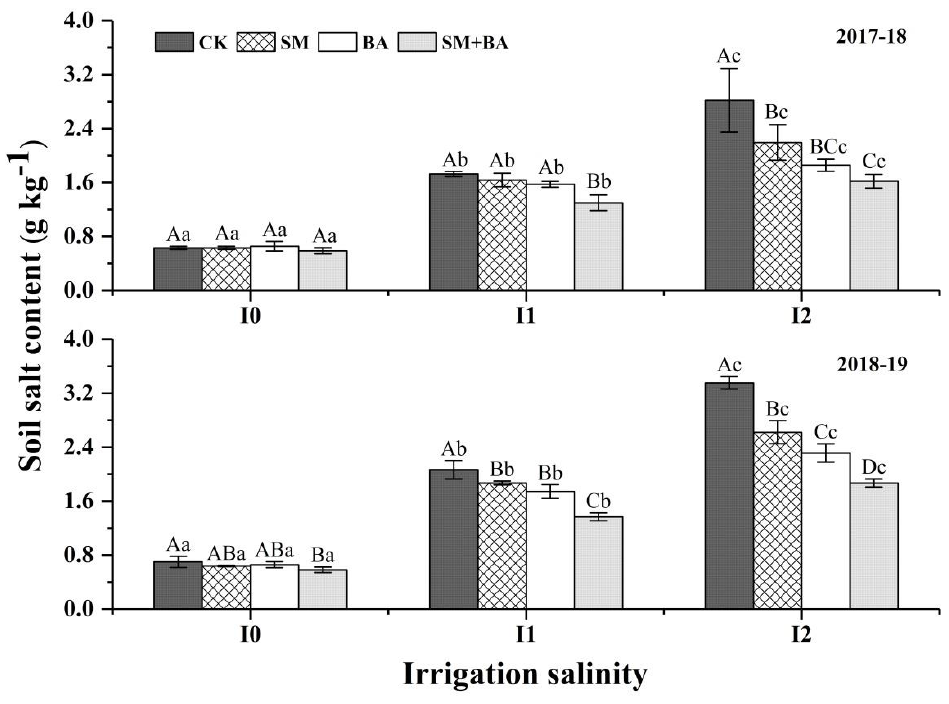
Figure 5. The effects of straw-returning modes and irrigation water salinity on soil salt content in 2017–2018 and 2018–2019, respectively. The values are means of three replications, ± standard deviation. For each growing season, different uppercase and lowercase letters indicate a significant difference ( p < 0.05) among straw-returning modes (for a given irrigation regime) and irrigation water salinity levels, respectively. CK: no straw-returning, SM: straw mulching, BA: biochar amendment, SM+BA: straw mulching with biochar amendment; I0, I1, and I2 indicate an irrigation salinity of 0.47 dS m −1 , 3.25 dS m − 1 , and 6.75 dS m −1 , respectively.